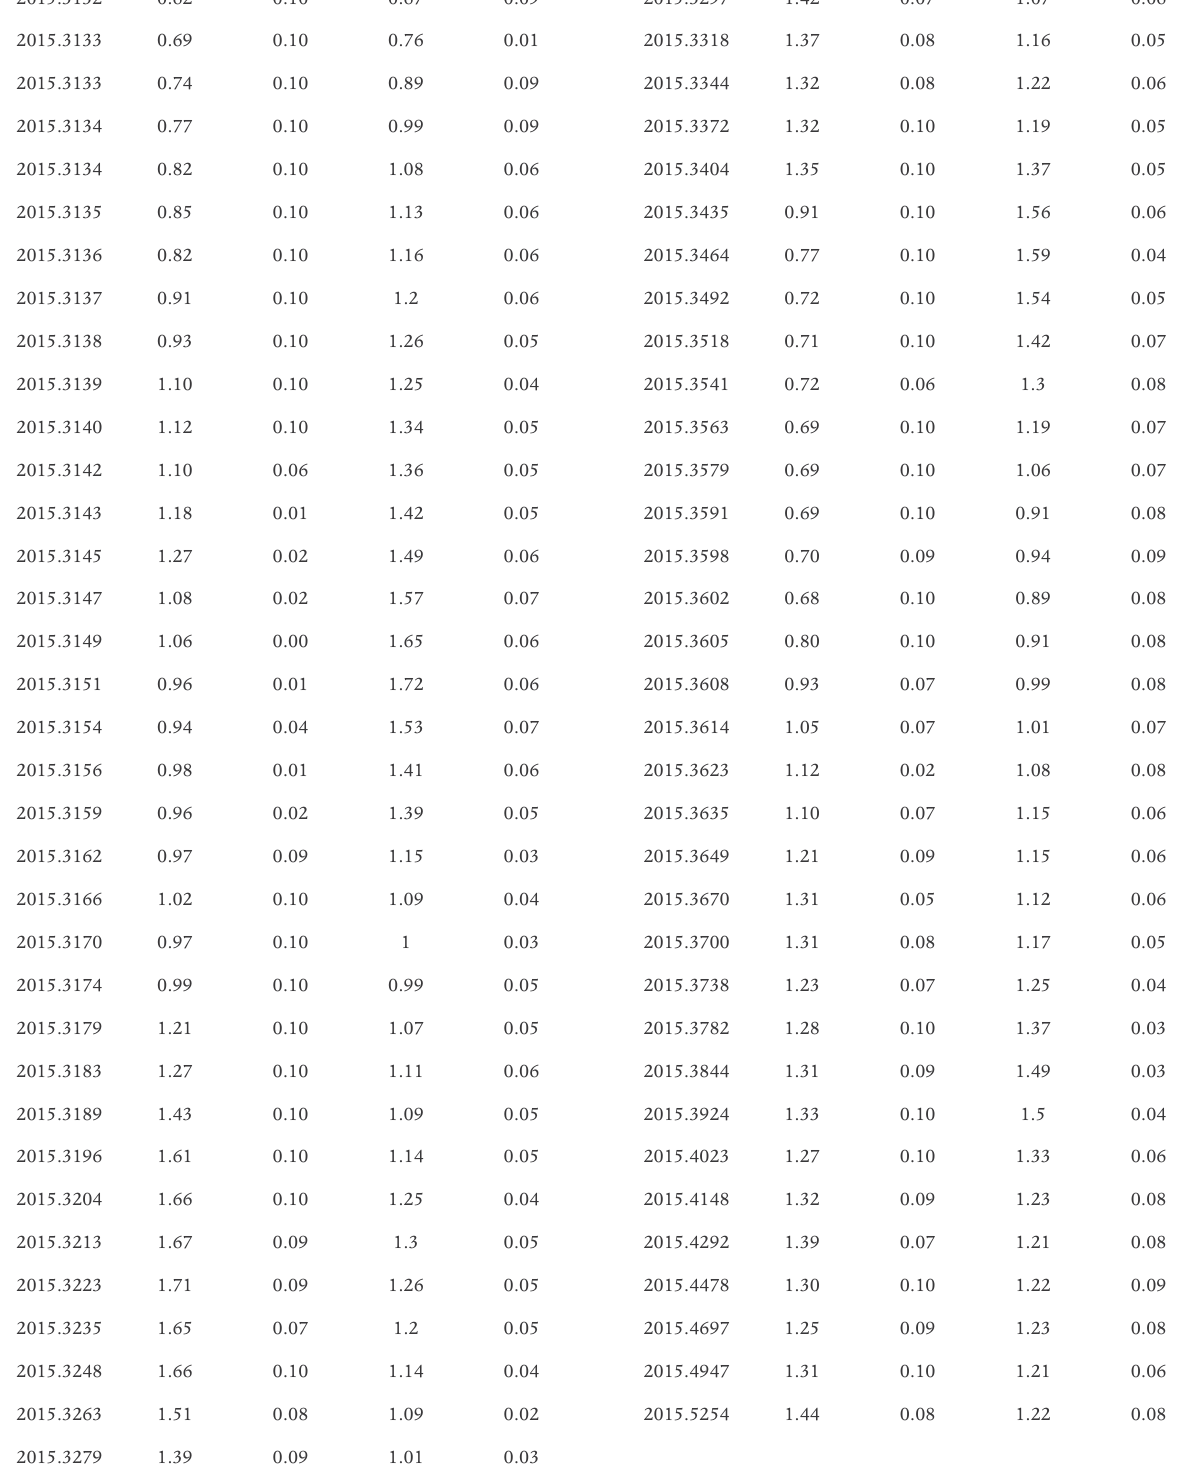
, during the period April 25 - October C